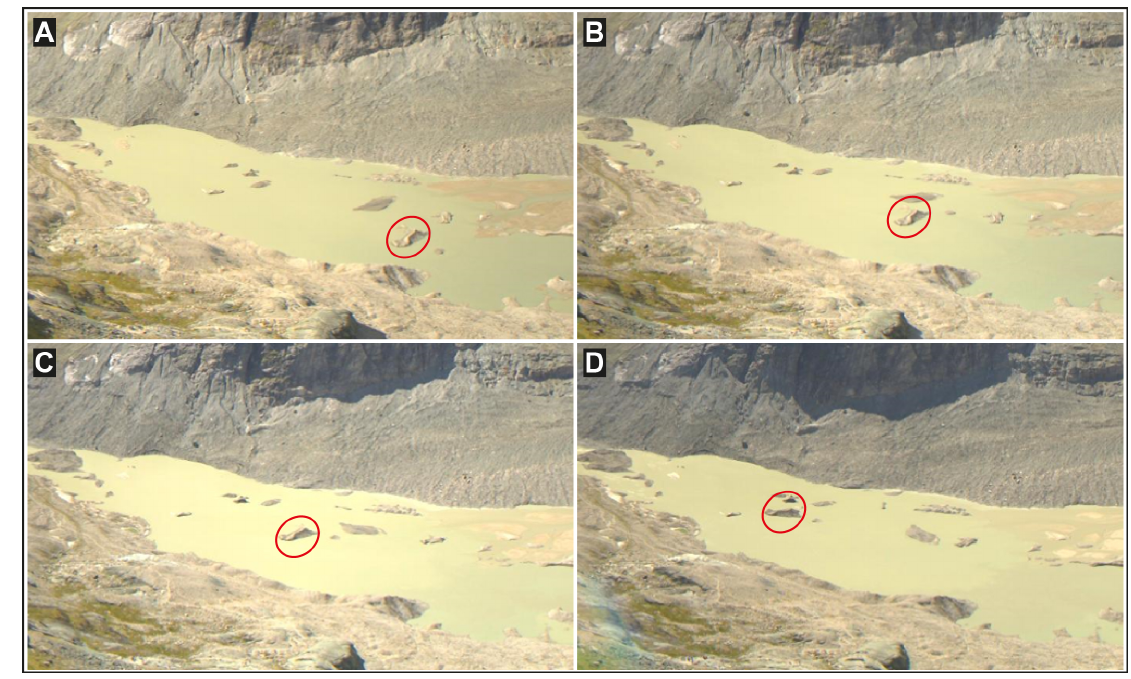
Figure 5. Examples of the high dynamics of icebergs on Lake Pasterzensee (2015-08-28). The iceberg moves about 500 m in 3 h (11:00–14:00 CEST): ( A ) 11:00; ( B ) 12:00; ( C ) 13:00; and ( D ) 14:00.